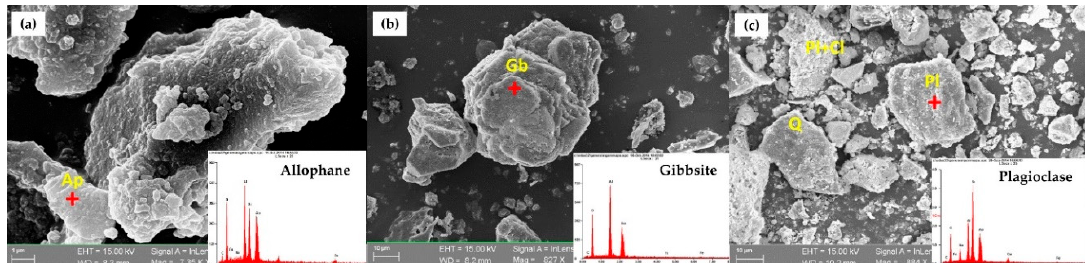
Figure 4. Scanning electron microscope/energy-dispersive X-ray spectroscopy (SEM/EDS) analysis after sequential extraction from Bw horizon of Noro in Jeju Island, showing ( a ) allophane formed on the surface of plagioclase before extracting, ( b ) removal of allophane after step 4, and ( c ) crystalline minerals after step 5. Ap: allophane, Gb: gibbsite, Q: Quartz, Pl: Plagioclase, Cl: Clay minerals.